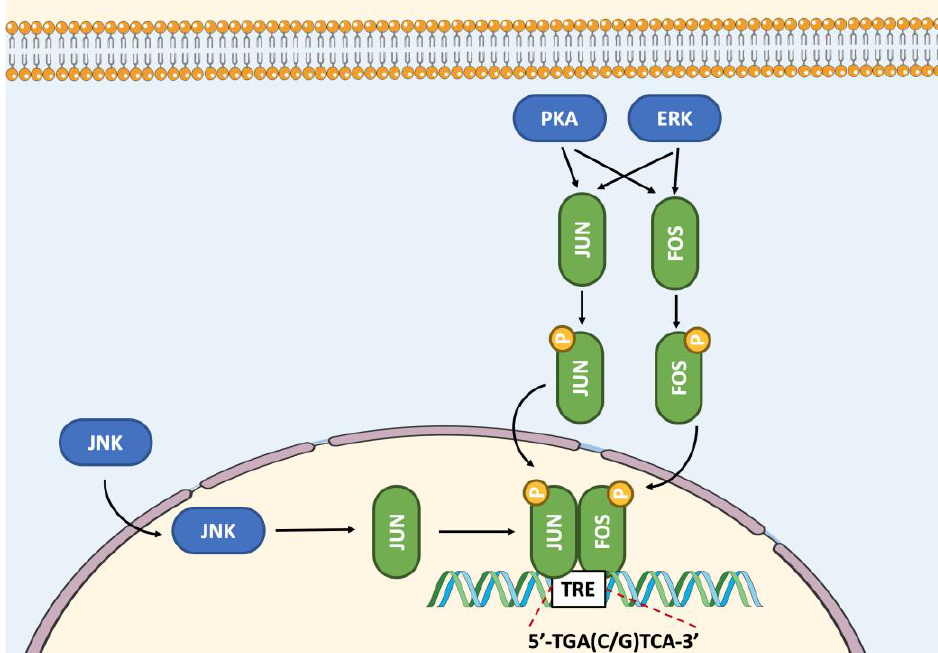
Figure 3. Regulation of the activity of AP-1 family members JUN and FOS by phosphorylation, followed by recruitment to the TRE DNA regulatory element. Abbreviations: ERK, extracellular signal-regulated kinase; JNK, JUN N-terminal kinase; P, phosphate; PKA, protein kinase A; TRE, 12-O-tetradecanoylphorbol-13-acetate response element.